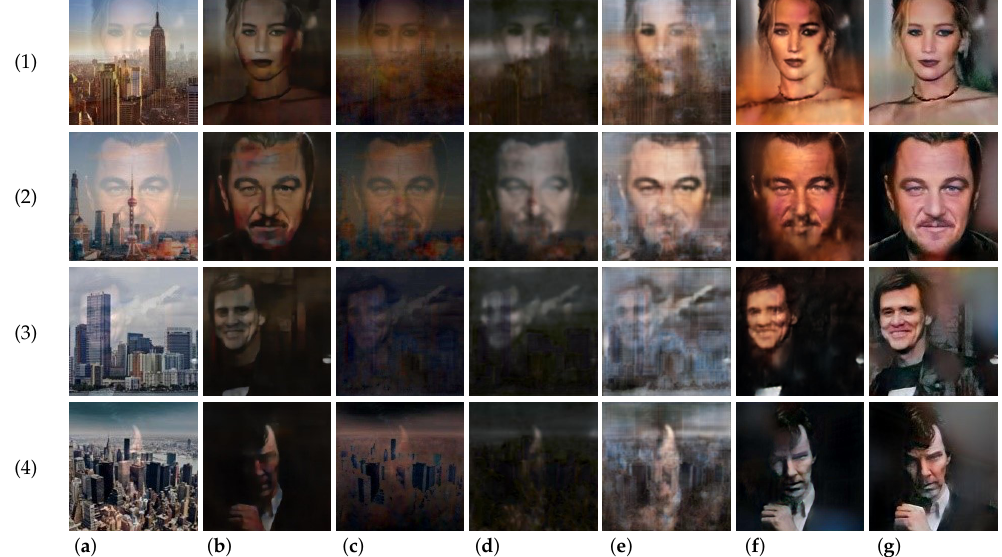
Figure 14. Four recovery examples of the reflection layers containing portrait scenes. ( a ) Mixture image, ( b ) [13], ( c ) [14], ( d ) [16], ( e ) [17], ( f ) Ours(a), ( g ) Ours(b).